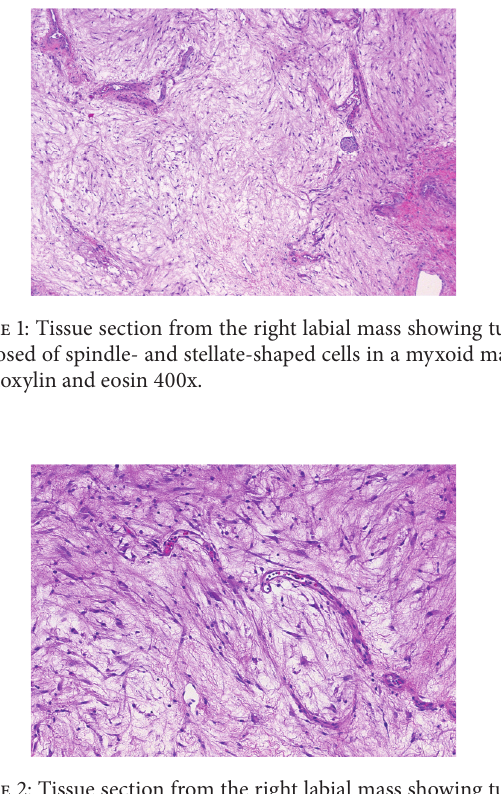
Figure 2: Tissue section from the right labial mass showing tumor composed of capillary spindle-shaped channels, hematoxylin and eosin